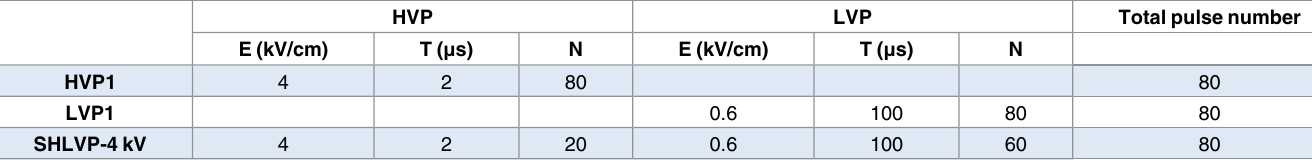
Table 5. Schemes for pulsation protocols with the same pulse